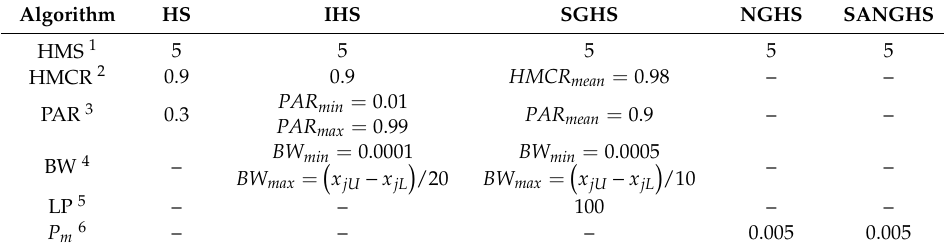
Table 1. Parameters of compared harmony search (HS) algorithms in ten optimization